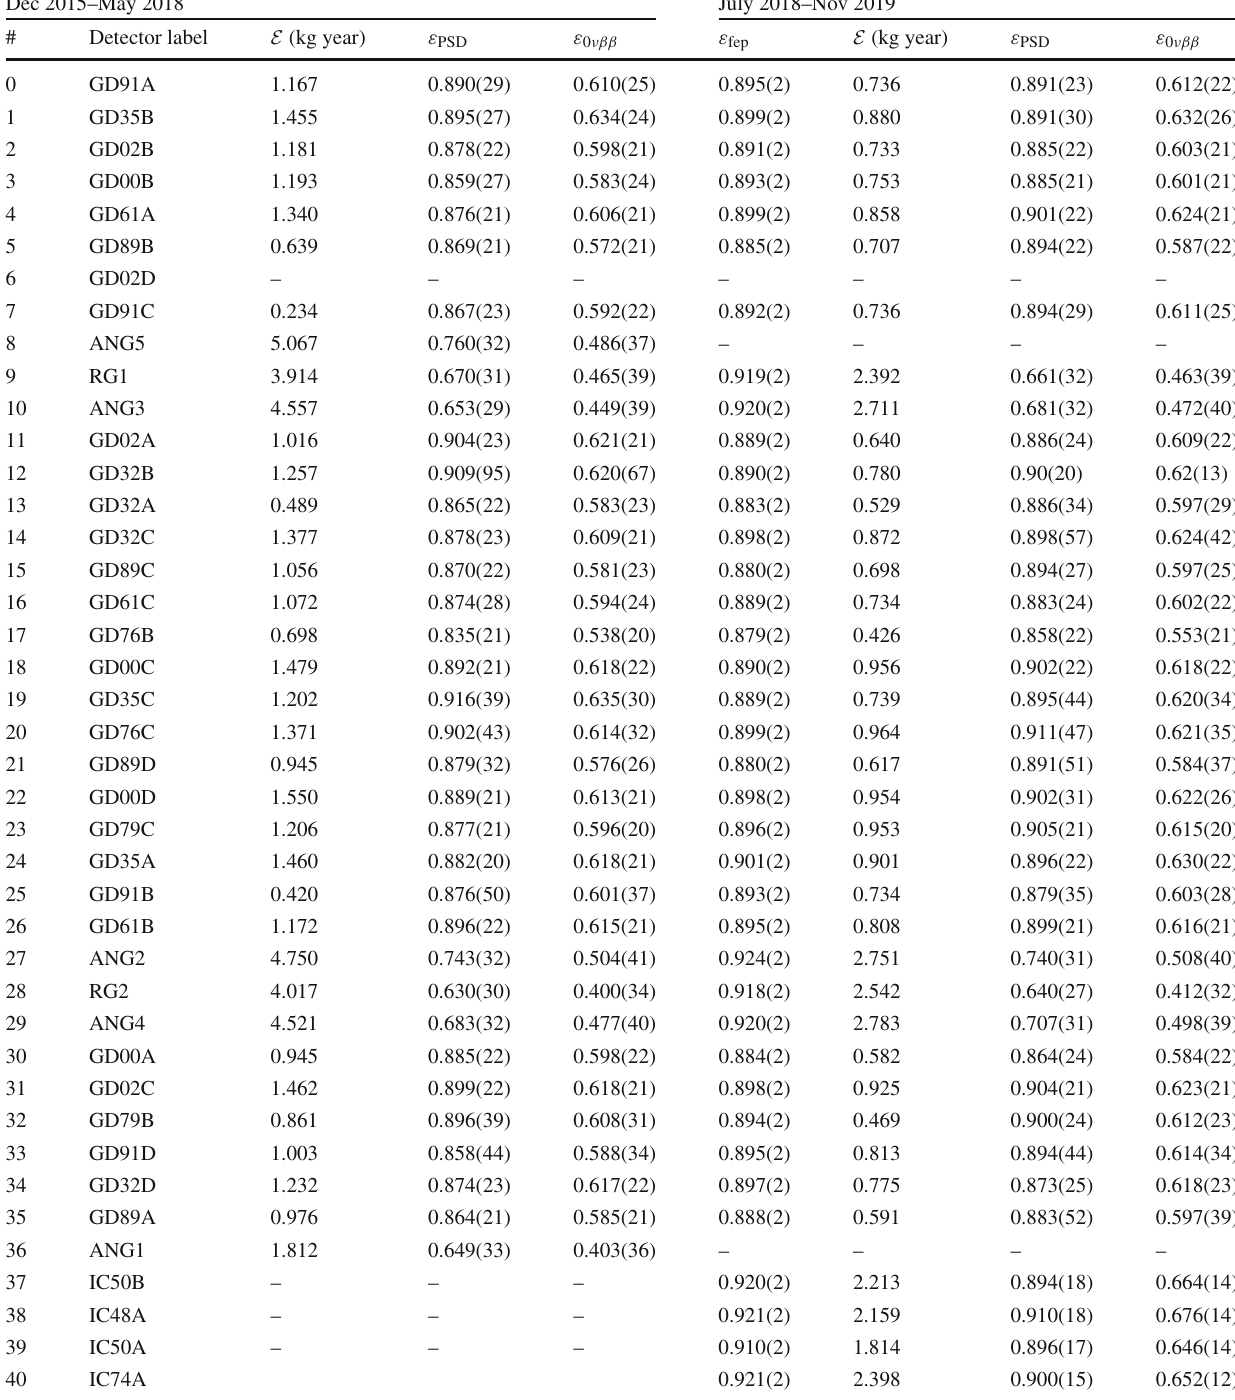
Table3 Detector-wisePSDcutefficiencies ε PSD andthetotaldetection efficiencies ε 0 νββ for 0 νββ decays used in the final analysis of [26] and corresponding exposures E . For the period after the 2018 upgrade also